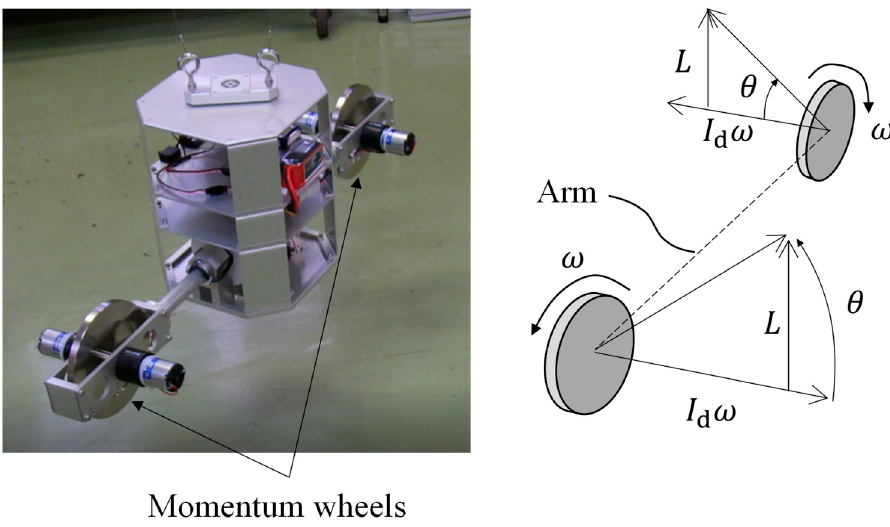
Figure 2. Structure of the attitude controller.